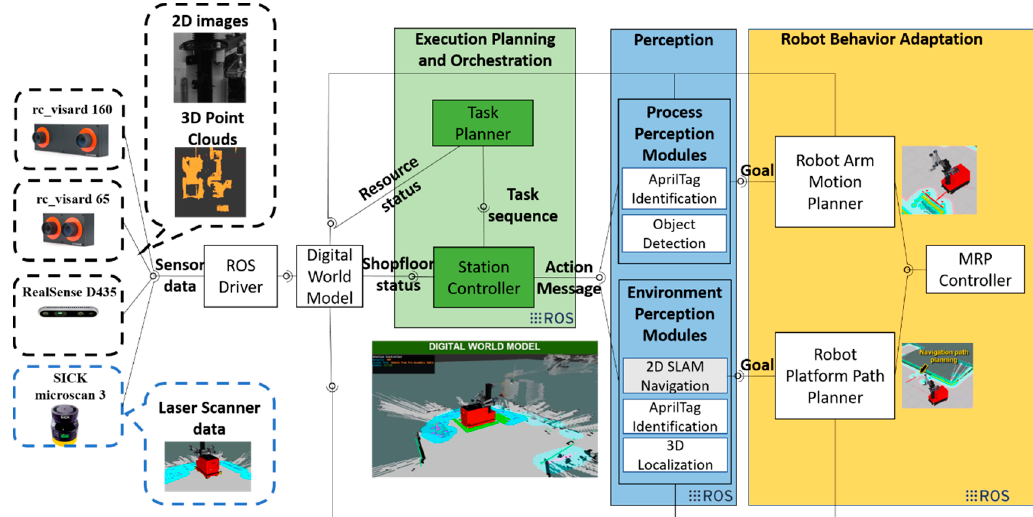
Figure 3. Shopfloor and process perception system architecture—overall approach .